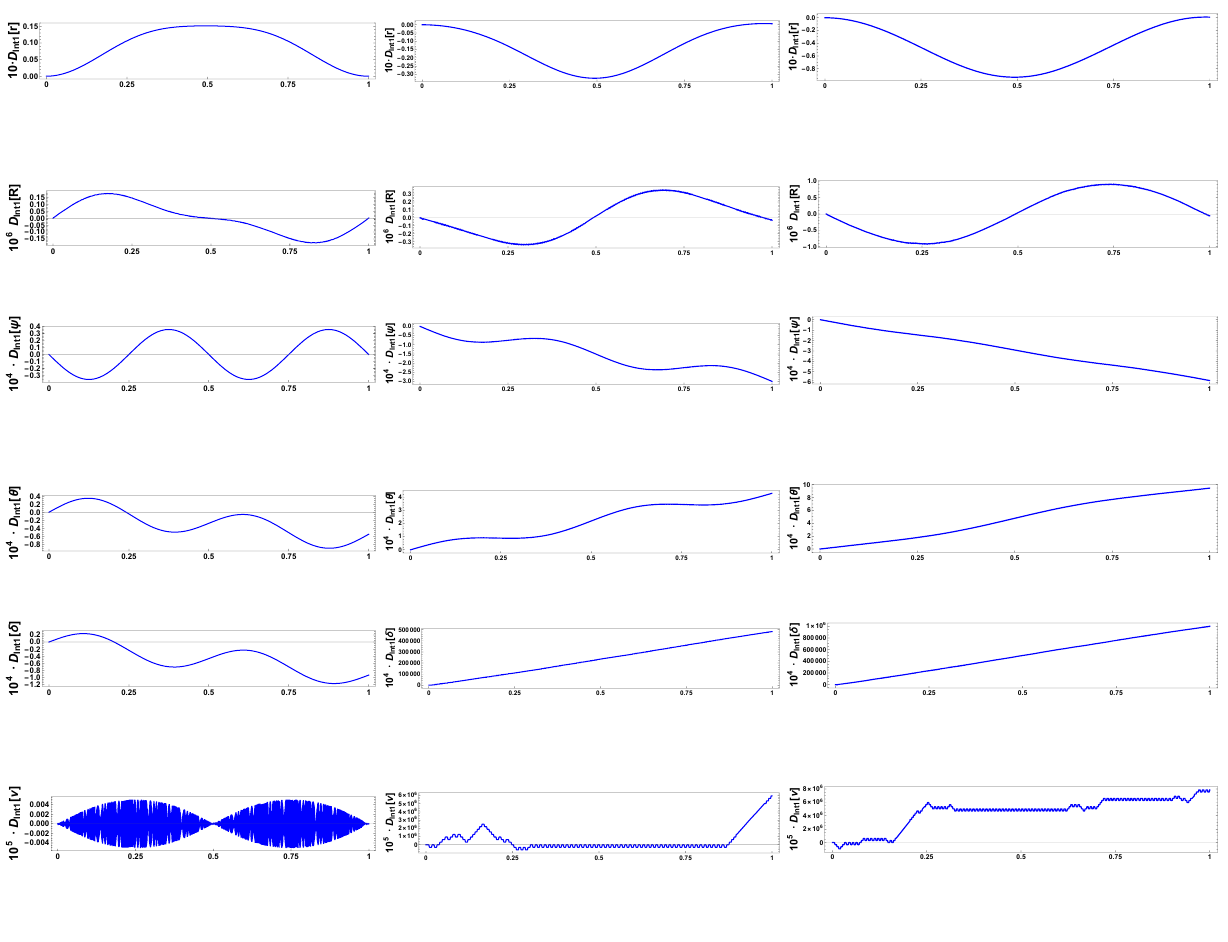
Fig. 3 Columns from left to right we have: (i) ρ = 0 , A 1 = 9 . 80 · 10 20 , A 2 = 9 . 8 · 10 20 , A 3 = 1 . 07 · 10 21 . (ii) ρ = 0 . 15 , A 1 = 1 . 17 · 10 21 , A 2 = 1 . 23 · 10 21 , A 3 = 1 . 39 · 10 21 . (iii) ρ = 0 . 35 , A 1 = 1 . 06 · 10 21 , A 2 = 1 . 18 · 10 21 , A 3 = 1 . 28 · 10 21 . Abscissas are orbital periods and D [ x ] = x Full − x Intermediary . The orbital period is 10.8 hours and r is expressed in Km, which initially is set to 1.560 Km. Initial conditions for simulations in Figure 2 and Figure